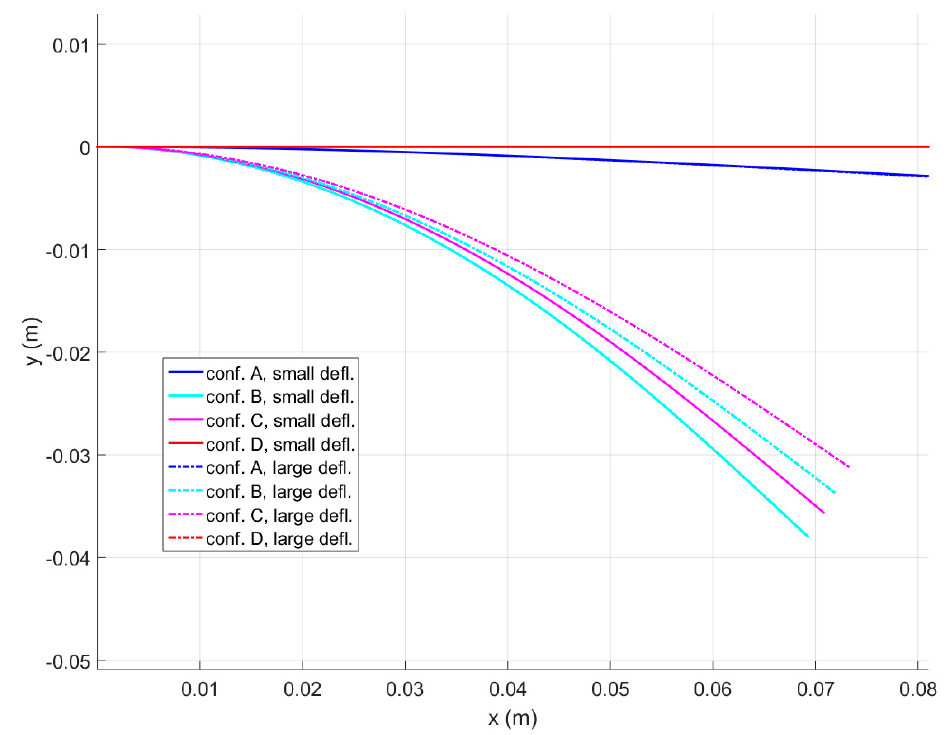
Figure 5. Vertical displacement of the laminate at the conditions A, B, C, and D of the process of Figure 4, in small and large displacement